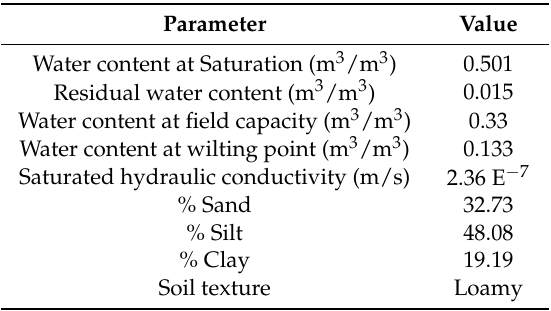
Table 1. Soil properties of Livraga study